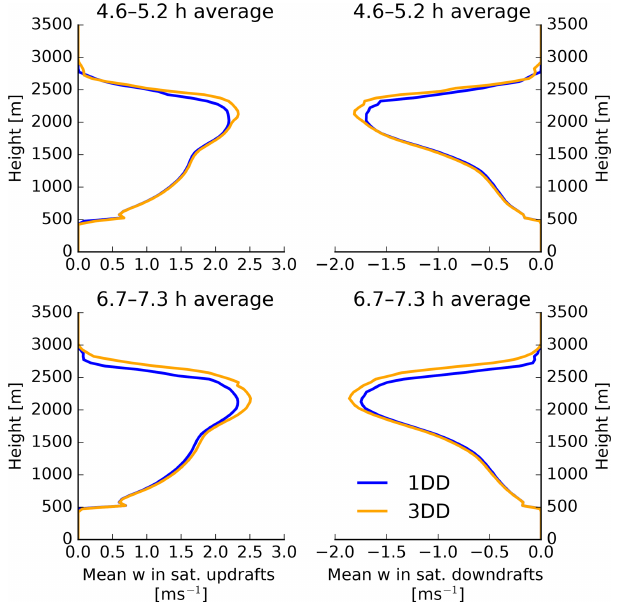
Figure 20. Similar to Fig. 18 but for 1 DD and 3 DD and for the time period between 4.6 and 5.3h as well as 6.7 and